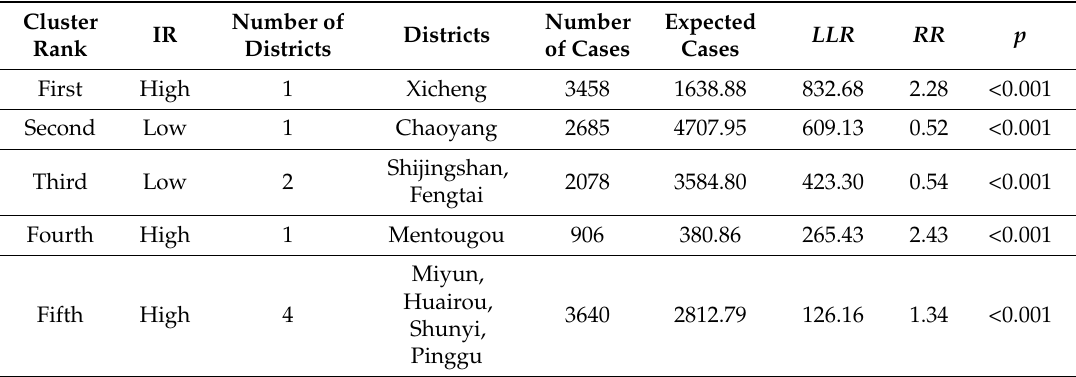
Table 1. Purely spatial scan statistics analysis of high and low IRs from 2009 to 2014.